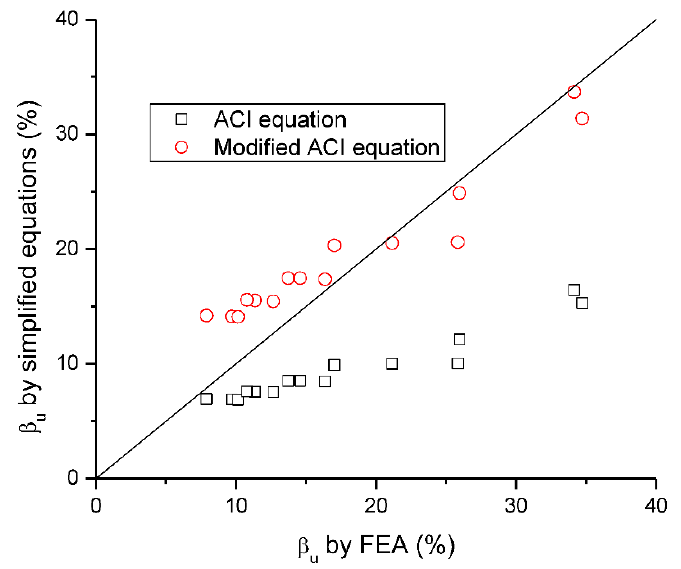
Figure 19. Correlation of β u by simplified equations with FEA.